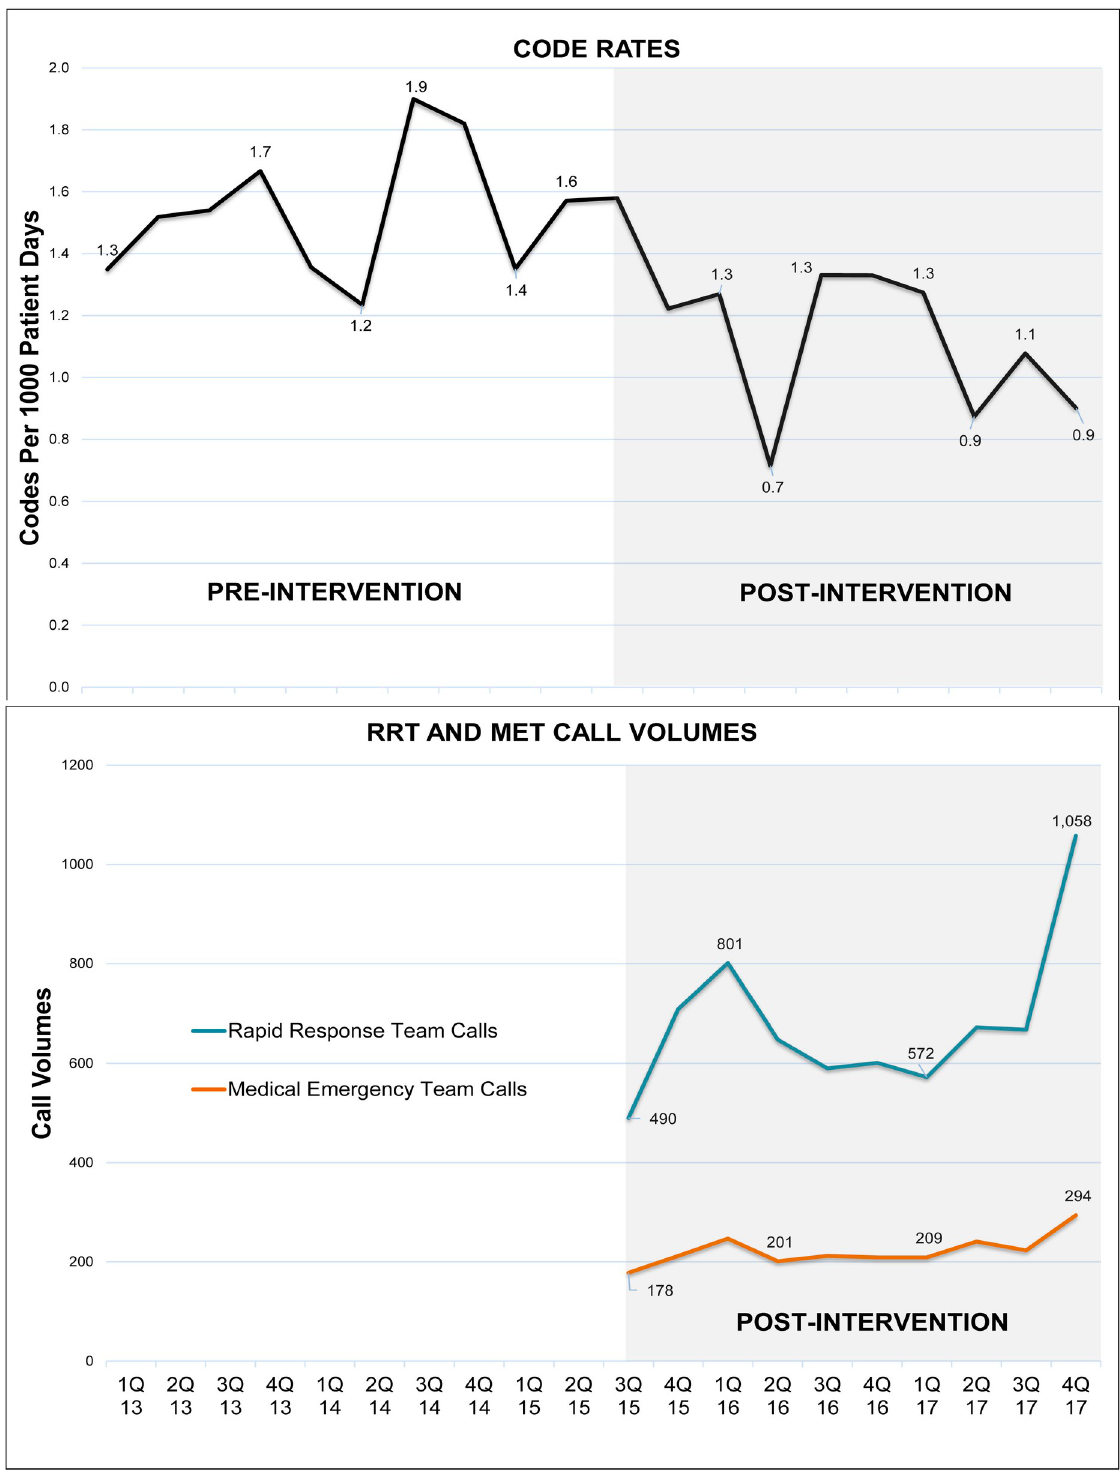
Fig 2. Code rate and RRT & MET call volume trends.